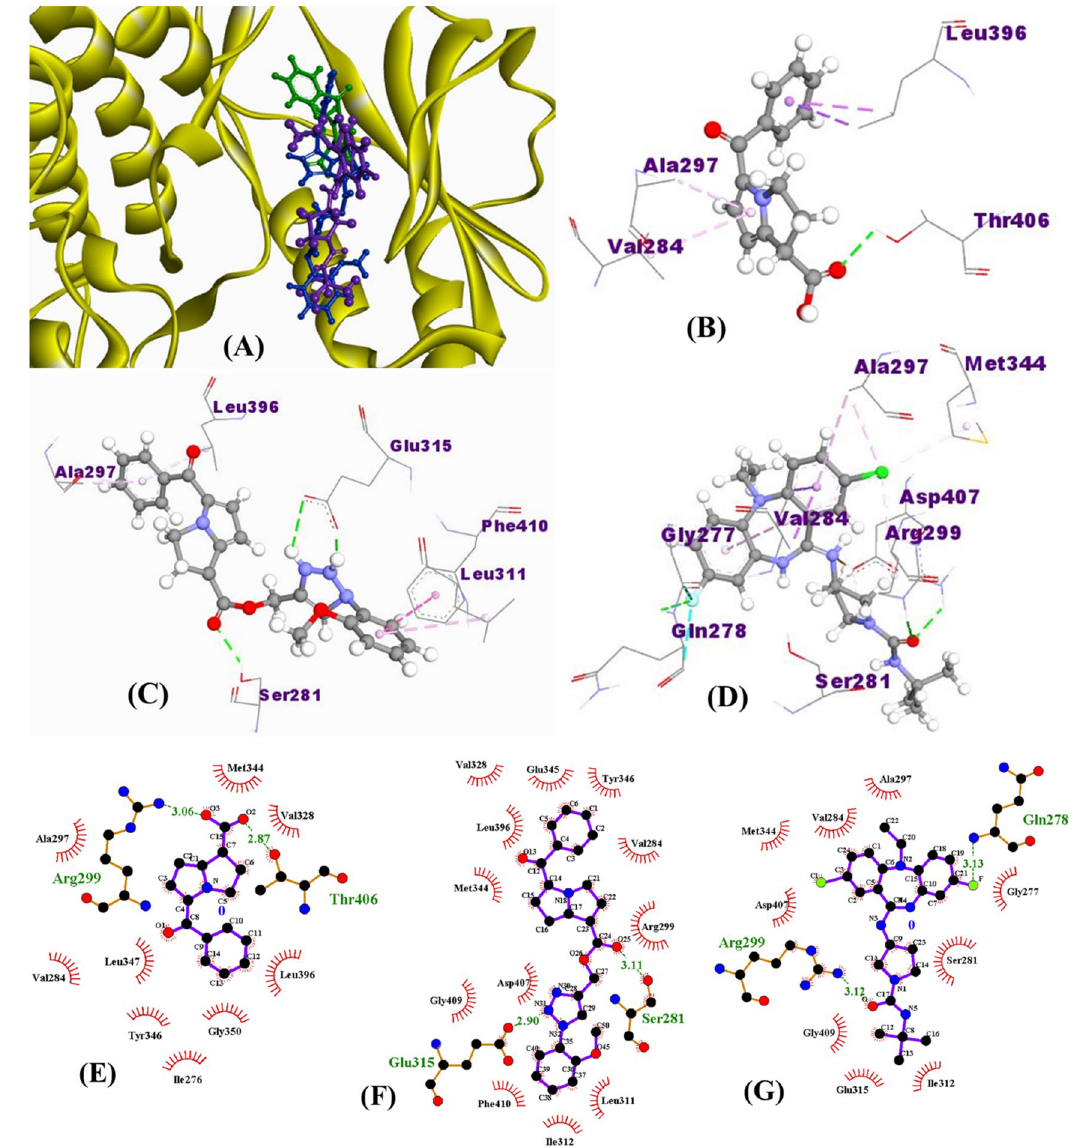
Figure 4. Binding orientation of ketorolac (green), 15K (blue), and inhibitor 2 (magenta) in the catalytic sites of PAK1 (PDB ID: 3Q52, Resolution: 1.80 Å) ( A ). Non-bonding interactions of ketorolac ( B ), 15K ( C ), and inhibitor 2 ( D ) with different PAK1 residues as determined by Discovery Studio 4.5. Green dashed lines in B , C , and D represent hydrogen bond interaction. Molecular interactions of ketorolac ( E ), 15K ( F ), and inhibitor 2 ( G ) with PAK1 residues were cross-checked by LigPlot+. PAK1 residues with green color text in E-G are responsible for hydrogen bond formation with the Multiple receptor conformers based molecular docking. Two types of PAK1 conformers generated trajectories (0.1, 5, 10, 15,… 0.100 ns) obtained from 100 ns run. Inhibitor 2 demonstrates an average binding affinity of − 7.9 kcal/mol, whereas 15K shows − 8.2 kcal/mol. Similarly, the binding affinity was higher for 15K ADMET, physicochemical, and pharmacological properties, and druglikeness of 15K. tribution, metabolism, excretion, and toxicity (ADMET) play important roles. Through an in silico ADMET analysis, 15K shows poor aqueous solubility (log mol/L = − 4.26) (Table 7), indicating poor absorption via oral administration. The ADMET table (Table 7) also expresses that 15K could be distributed in blood stream only and is not able to cross the blood brain barrier (BBB) and in turn it could not pose any psychological side effect.